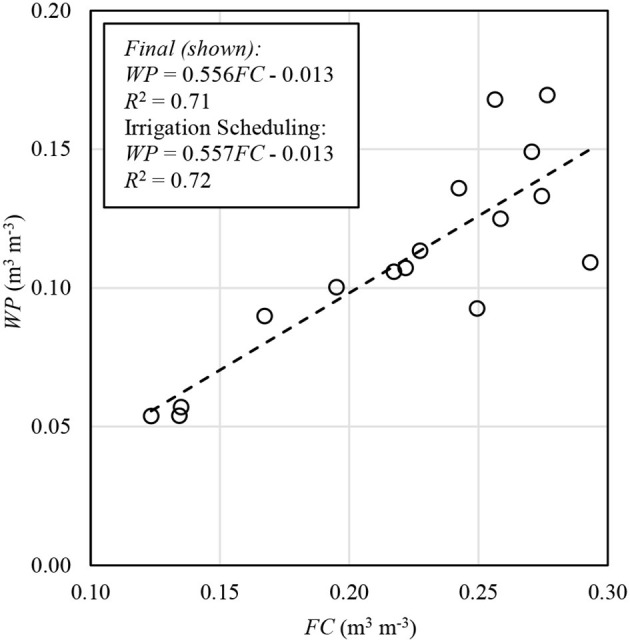
Linear regression fit of permanent wilting point (WP) as a function of plot field capacity (FC) from 2017 observations.